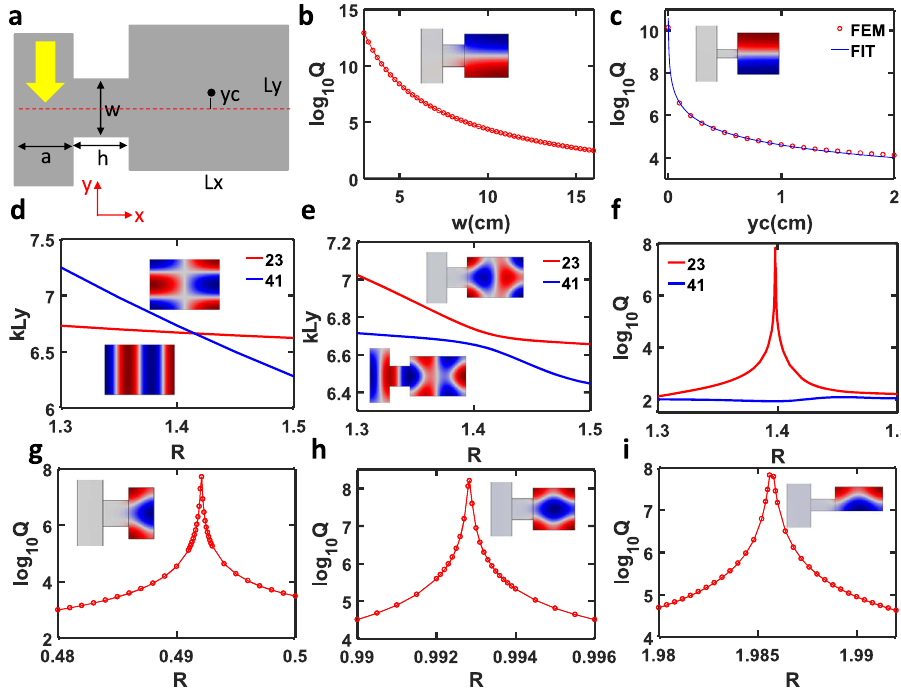
Fig. 2 BIC in an open acoustic resonator. a Schematic drawing of an open acoustic resonator, where an acoustic waveguide is coupled to a rectangular resonator. b Q -factor of mode M 12 vs. neck width. c Q -factor of mode M 12 vs. y c . d eigenfrequency kLy of modes M 41 and M 23 vs. size ratio in a closed resonator. e eigenfrequency kLy of modes M 41 and M 23 vs size ratio in an open resonator. f Q -factor of modes M 41 and M 23 vs. size ratio in an open resonator. g Q -factor of mode M 13 in a half-open resonator. h Q -factor of mode M 13 in a full resonator. i Q -factor of mode M 13 in another half